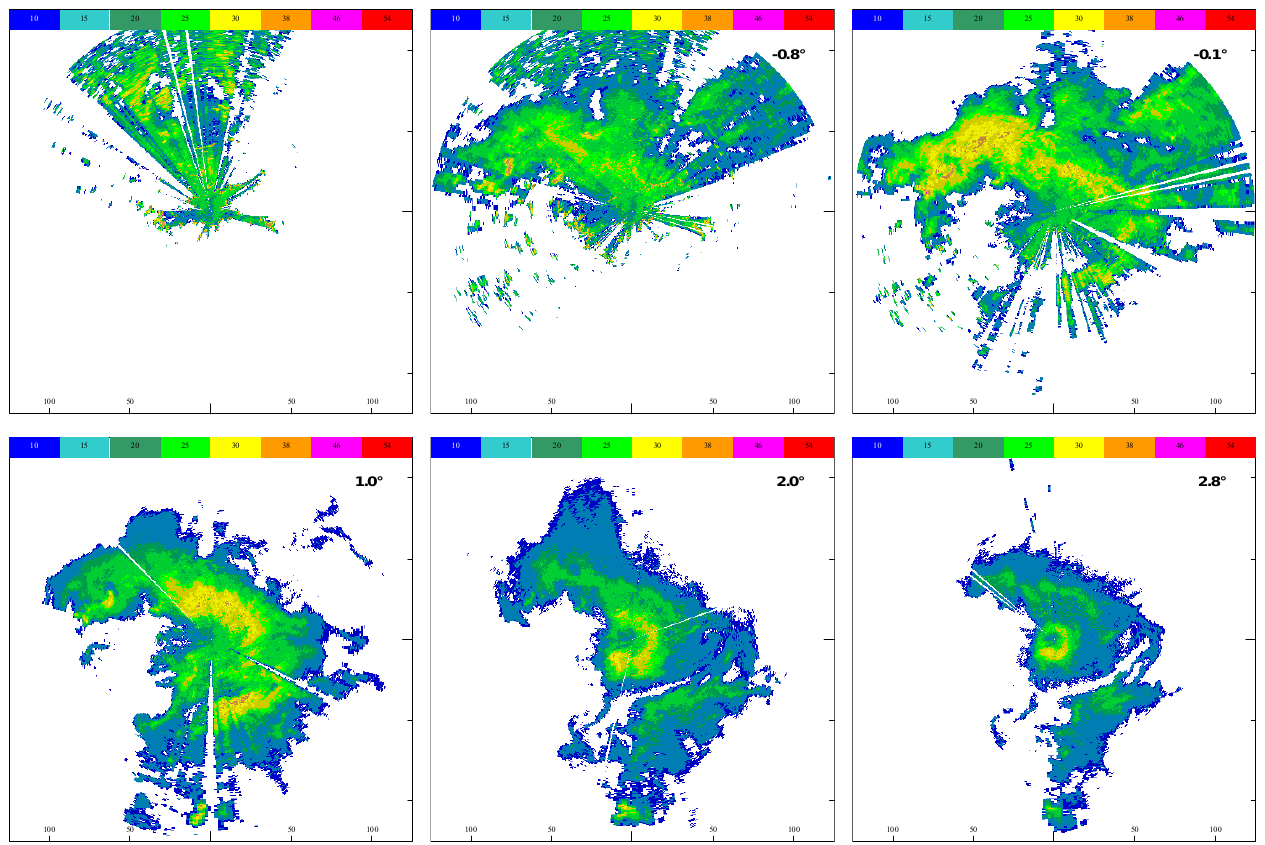
Fig. 2: PPI scans of Z H [dBZ] at various elevation angles from –1.8° to 2.8° (August 28, 2007, 0837 UTC). Max. range 120 km. Narrow white sectors are due to beam blocking or non-optimal signal processing. average Z DR of 3.1 dB at 60 ◦ and an average Z DR of 2.5 dB at 90 ◦ elevation was measured. This indicates that there is